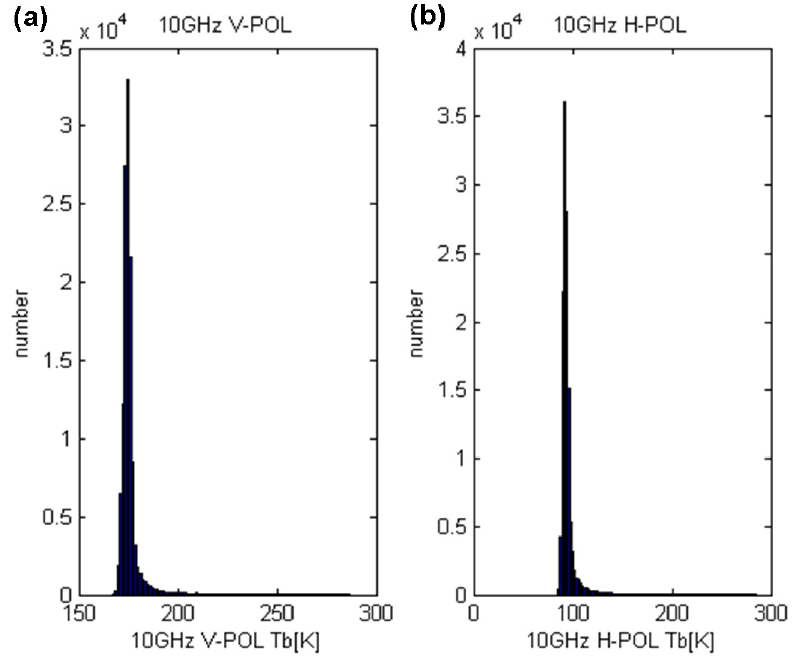
Figure 4. Histograms of the TB for the TMI in the absence of rain: ( a ) TB10V and ( b )